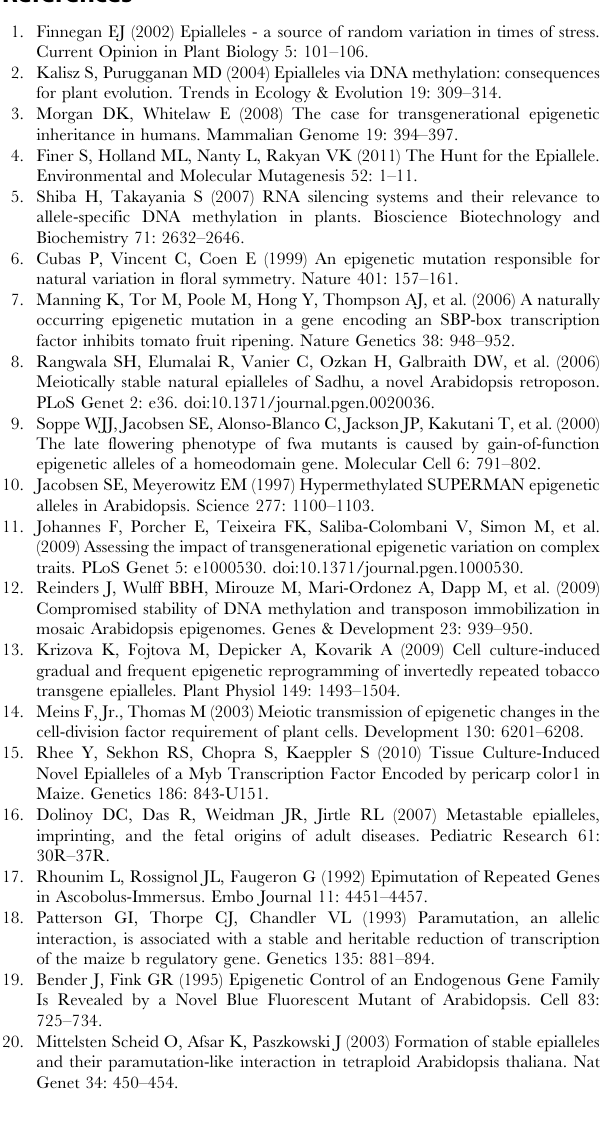
Table S4 Primer